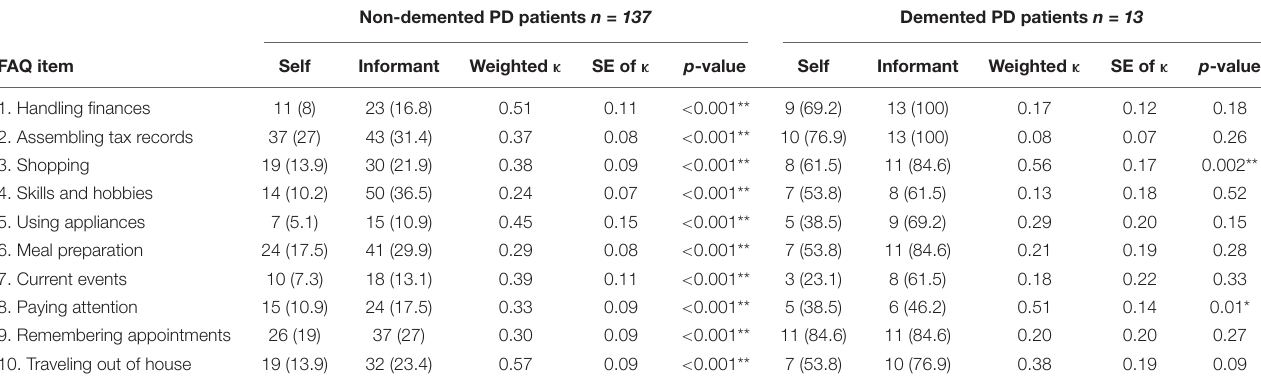
TABLE 3 | Agreement between self and informant ratings of the FAQ according to cognitive status. Non-demented PD patients n = 137 Demented PD patients n = 13 FAQ